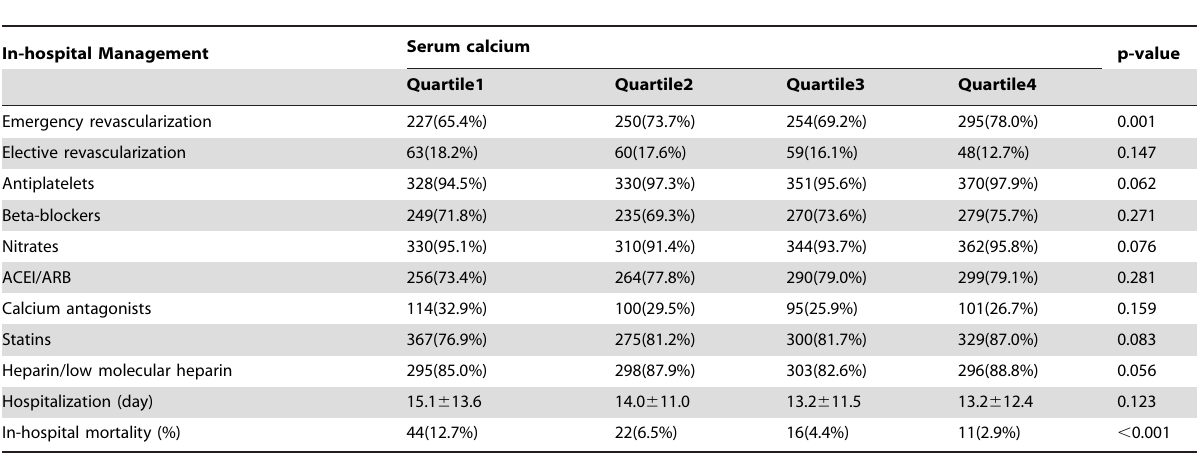
Table 2. In-hospital management and mortality of the STEMI patients according to serum